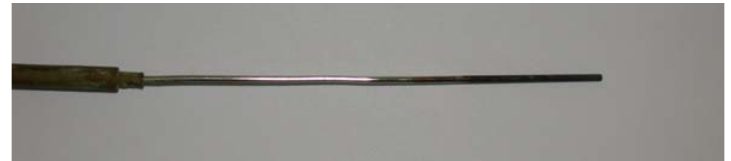
O -sensitive temperature sensor. 2 2